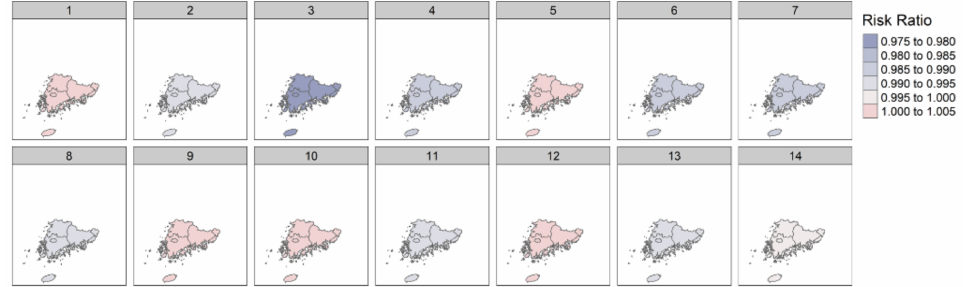
Figure 3. Association between DTR and amputation of diabetic foot in region